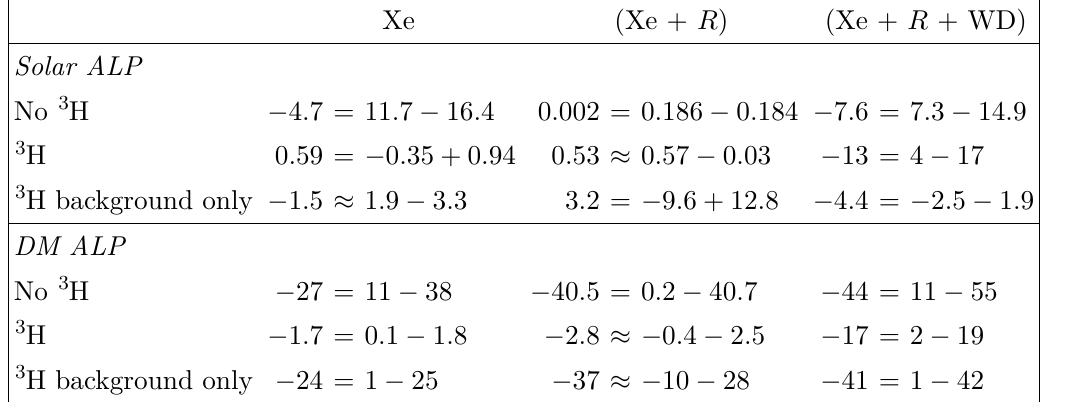
Table 6. Difference in Deviance Information Criterion (DIC) between the solar and DM ALP models and the background only model for the Xe data, when adding the R parameter, and finally when adding the WD hints. Positive (negative) differences indicate that the ALP (background- only) model was favoured. To emphasize the importance of the overfitting term p D we write our results as ∆ DIC = ∆ D + ∆(2 p D ) , where ∆ D is the difference between the two models in the mean deviance and ∆(2 p D ) is the difference in the overfitting